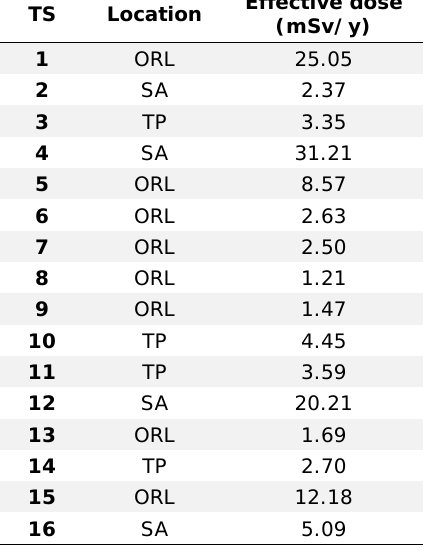
Table 3. Annual effective dose in the studied thermal spas